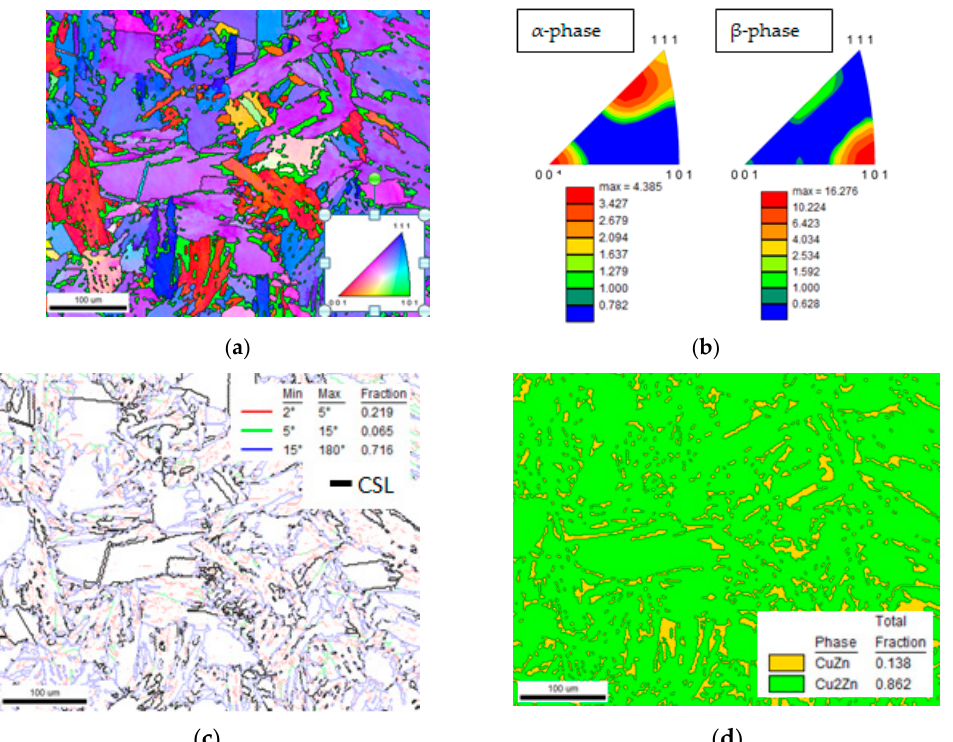
Figure 5. CuZn38As alloy in the as-drawn condition. ( a ) Inverse pole figure (IPF-Z) map and ( b ) texture plot. ( c ) Misorientation and ( d ) phase map. Note: CuZn ( β -phase), Cu2Zn ( α -phase). Unit: µ m.